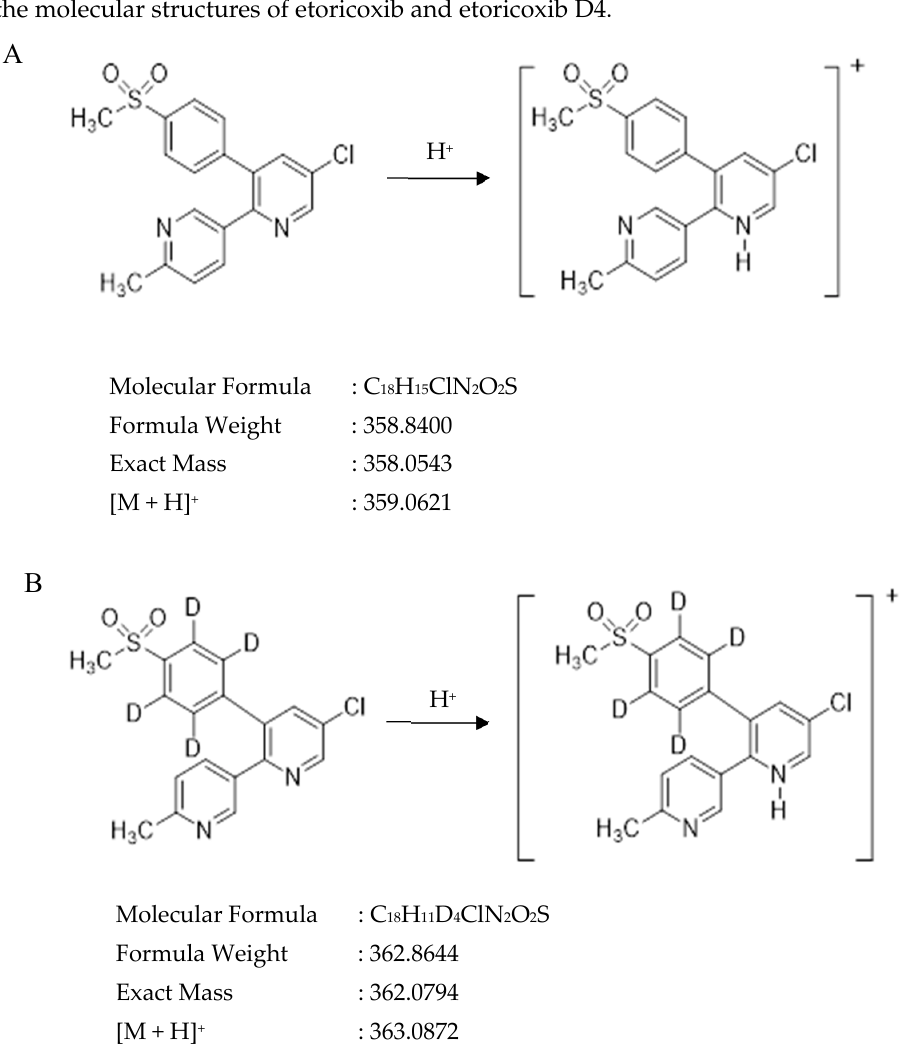
Figure 1. Molecular structures of ( A ) etoricoxib and ( B ) etoricoxib D4.